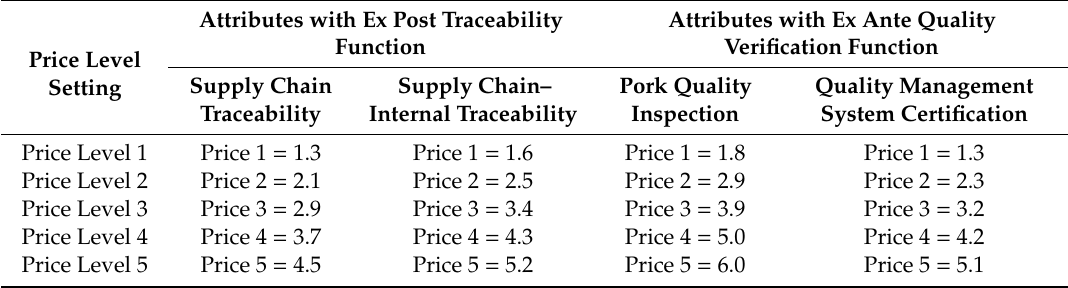
Table 3. Price levels of traceable pork attributes with di ff erent functions (price: yuan / 500